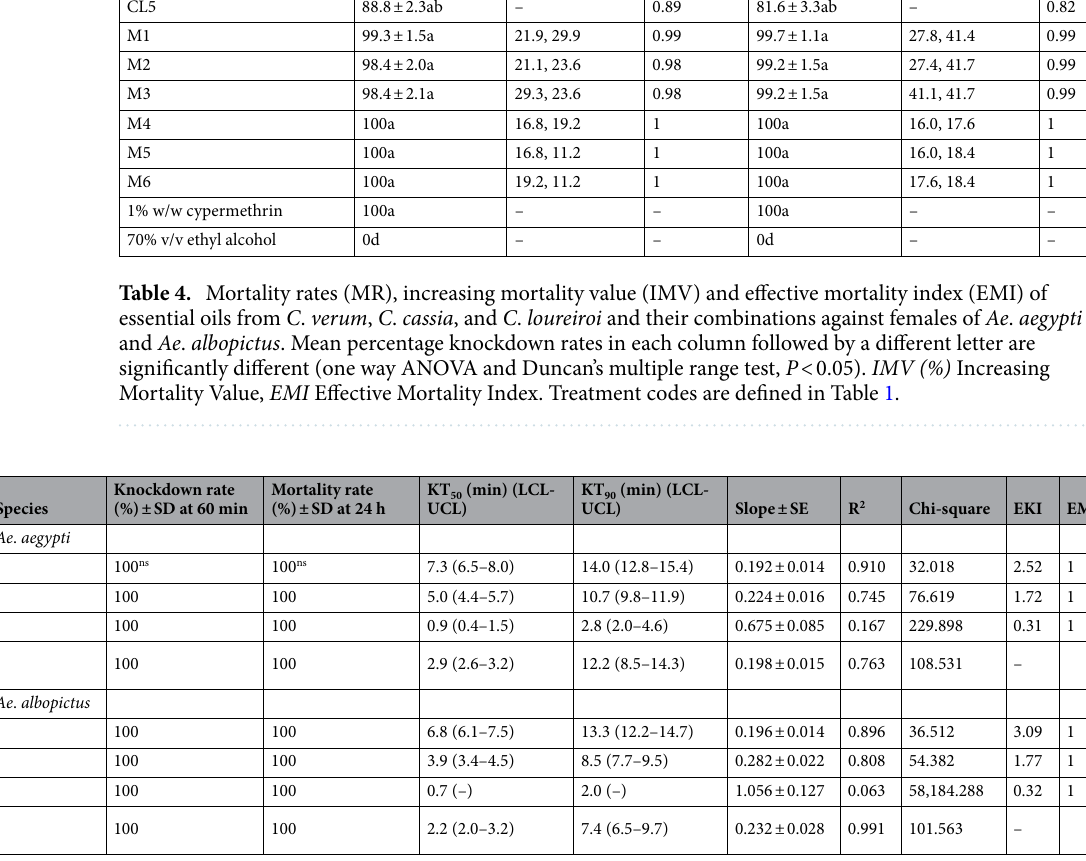
Table 5. Knockdown and mortality rates and KT 50 of cinnamaldehyde against females of Ae . aegypti and Ae . albopictus . KT 50 50% knockdown time, R 2 regression coefficient, LCL lower confidence limit, UCL